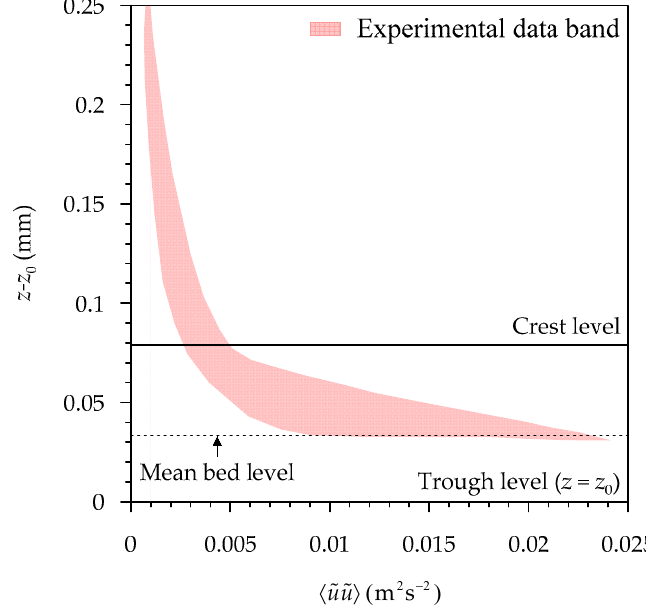
Figure 10. Variations of SA form-induced normal stress (cid:104) σ fuu (cid:105) ( = (cid:104) (cid:101) u (cid:101) u (cid:105) / ρ ) with z–z 0 in the WGB (data extracted from Aberle et al. [34]).